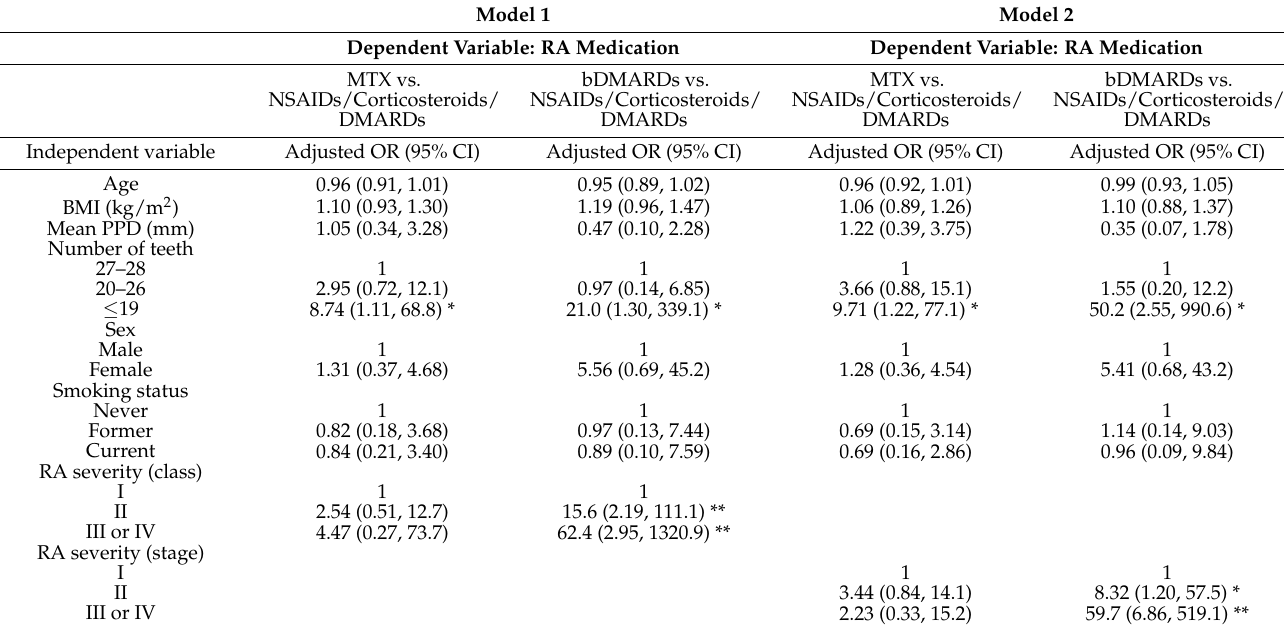
Table 4. Association of the number of teeth and other variables with RA medication by multivariate multinomial logistic regression